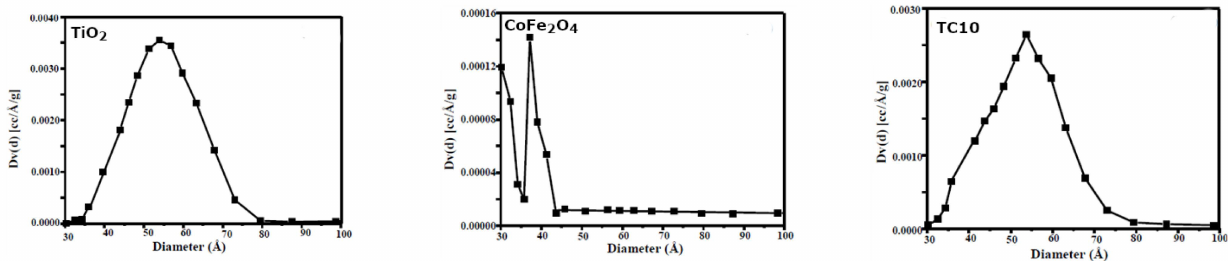
Figure 6. Pore size distribution curves of TiO 2 , CoFe 2 O 4 , and